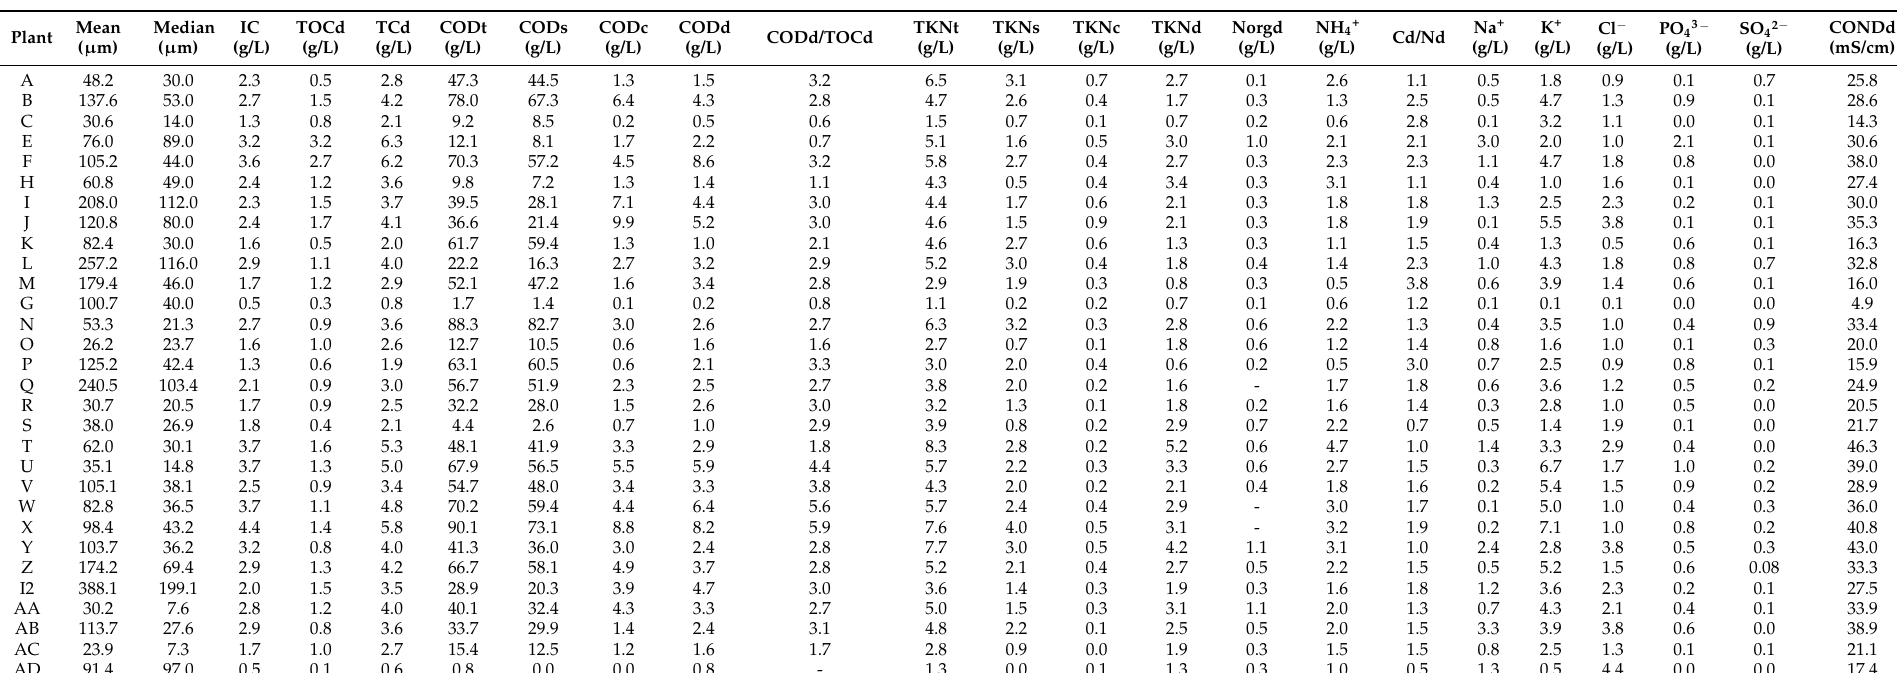
Table A3. Mean, median, inorganic carbon (IC), total organic carbon (TOC), total carbon (TC), chemical oxygen demand (COD), total kjeldahl nitrogen (TKN), ammonium (NH 4+ ), nitrogen (N), ammonium (NH 4+ ), carbon/nitrogen ration (C/N), sodium (Na + ), potassium (K + ), chlorine (Cl − ), phosphate (PO 43 − ), sulfate (SO 42 − ), conductivity